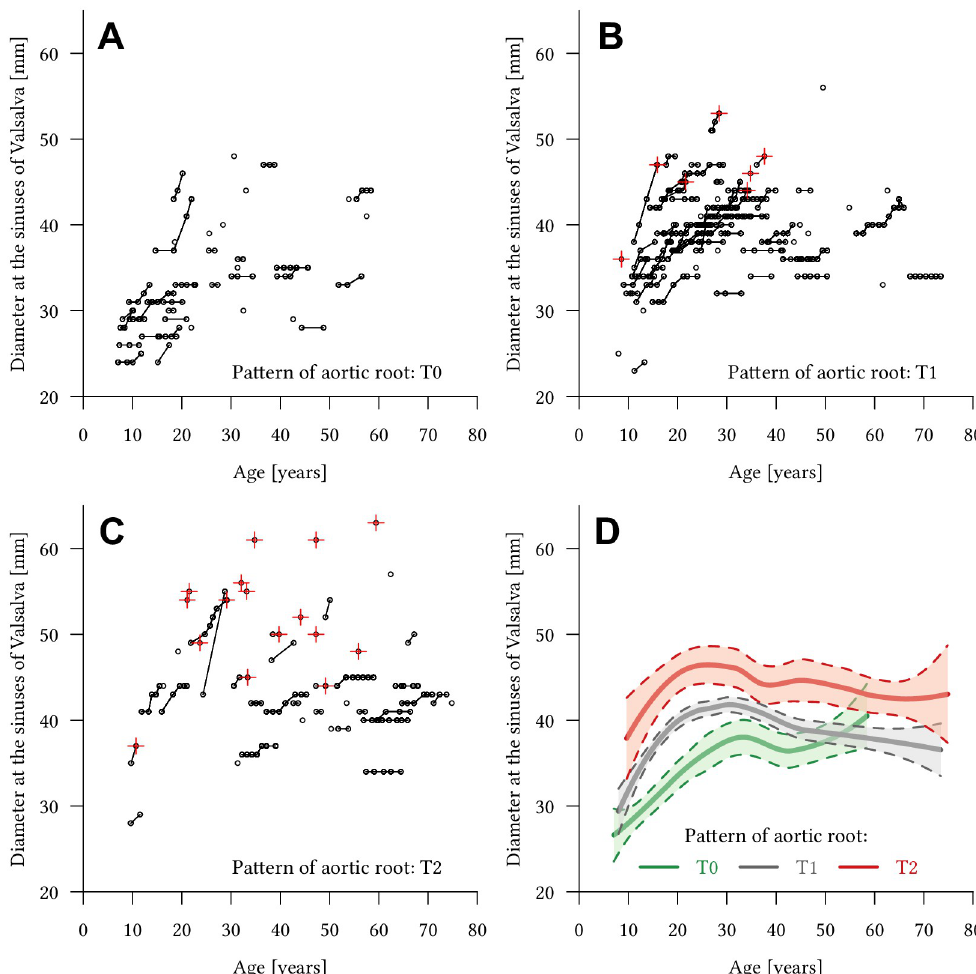
Fig 4. Spaghetti graphs of absolute aortic root diameters for different shapes of the aortic root in Marfan patients. Spaghetti graphs for all 160 Marfan patients with (A) normal aortic root shape (T0), (B) localized annulo-aortic dilatation (T1), and (C) generalized aortic root dilatation (T2). Red crosses indicate that the aortic MR angiography-derived aortic measurement was directly followed by aortic root replacement. Note that all of patients undergoing surgery had an altered shape of the aortic root (T1 or T2) and the high proportion of patients with generalized aortic root dilatation undergoing surgery (T2). (D) Local regression analysis of all three types of aortic root shape (T0 = green, T1 = grey, T2 = red) with 95% confidence intervals in all 160 Marfan